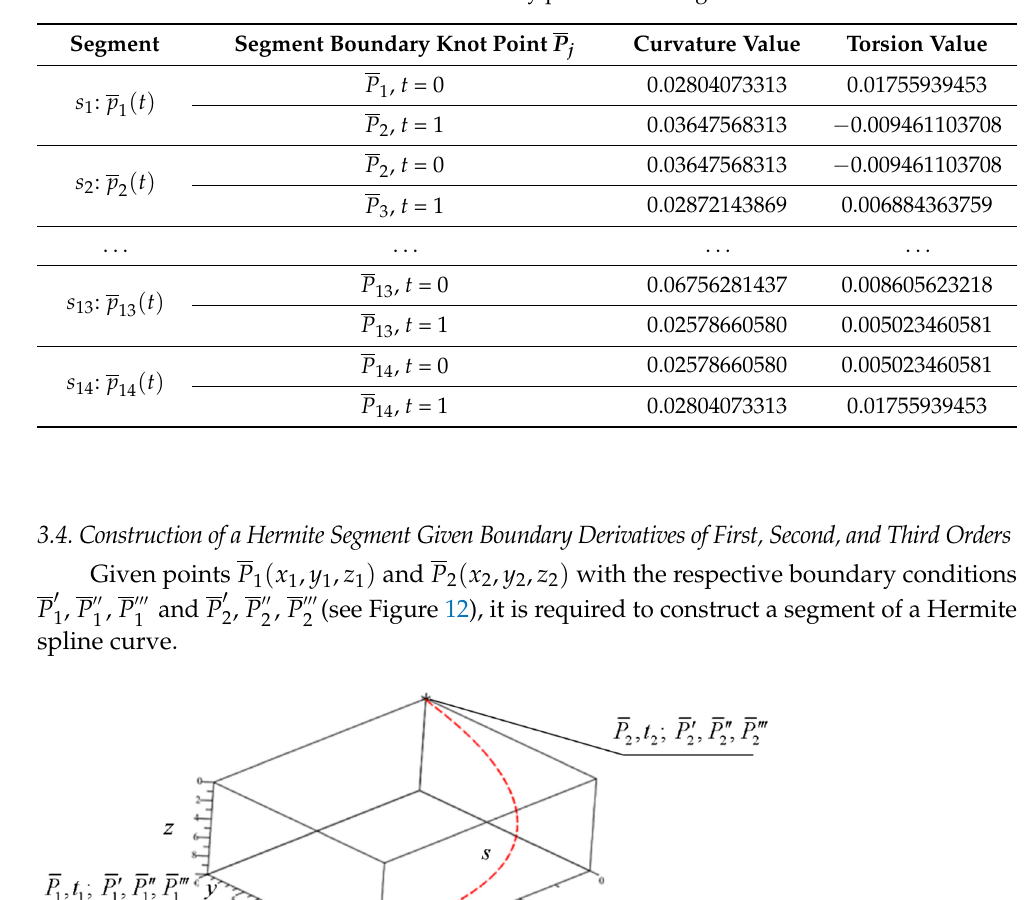
Figure 11. Closed fifth-degree Hermite spline curve of 14 segments. Table 4. Curvature and torsion values at boundary points of the segments.